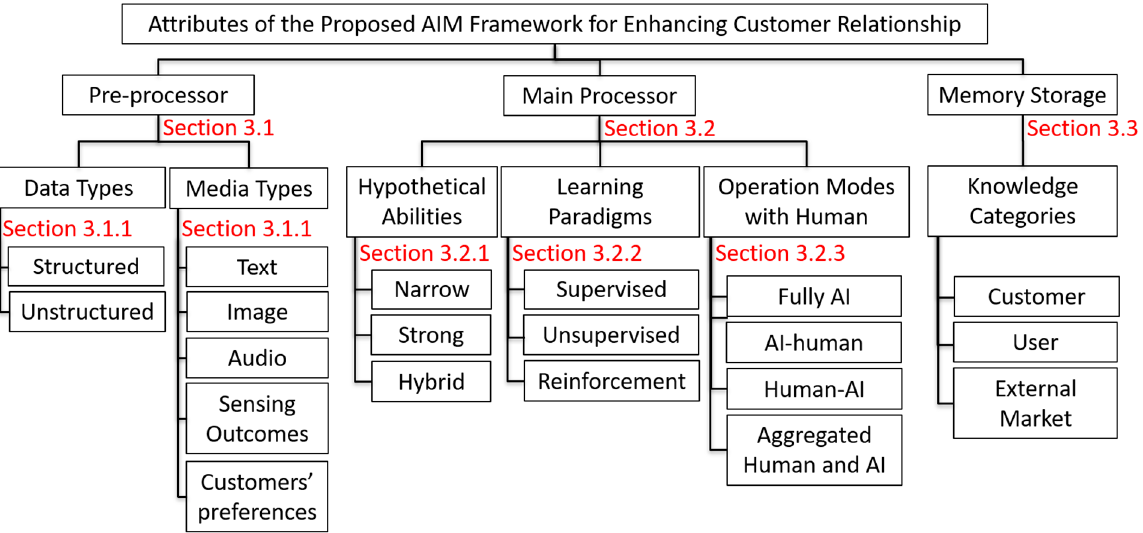
Figure 1. The AIM framework developed through a synthesis of the literature.